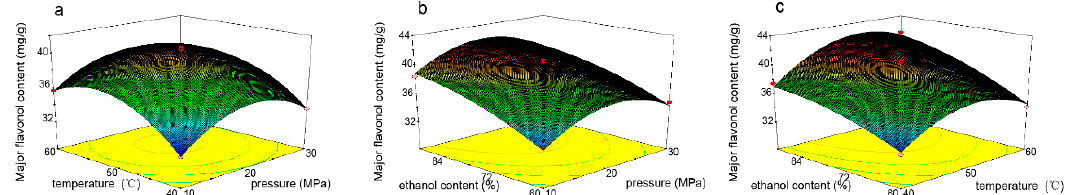
Figure 4. Response surface and contour plots of major flavonol content showing: ( a ) the effect of pressure and temperature at constant 75% ethanol concentration; ( b ) the effect of pressure and ethanol content at constant temperature 50 °C; ( c ) the effect of temperature and ethanol content at constant pressure 20 Mpa.